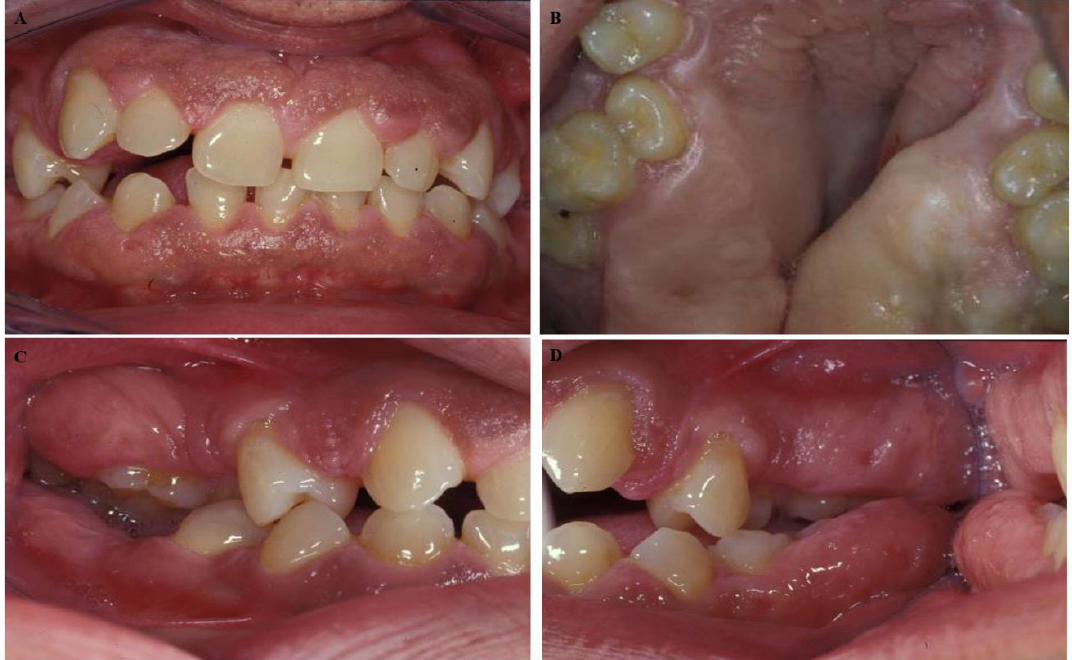
Figure 1. Intraoral images of a 50-year-old male. We observed ( A ) malocclusion with an anterior open bite, ( B ) rotation, tooth migration, ( C,D) diastemas, malposition and severe gingival enlargement that caused difficulties in speech, mastication, and hygiene.